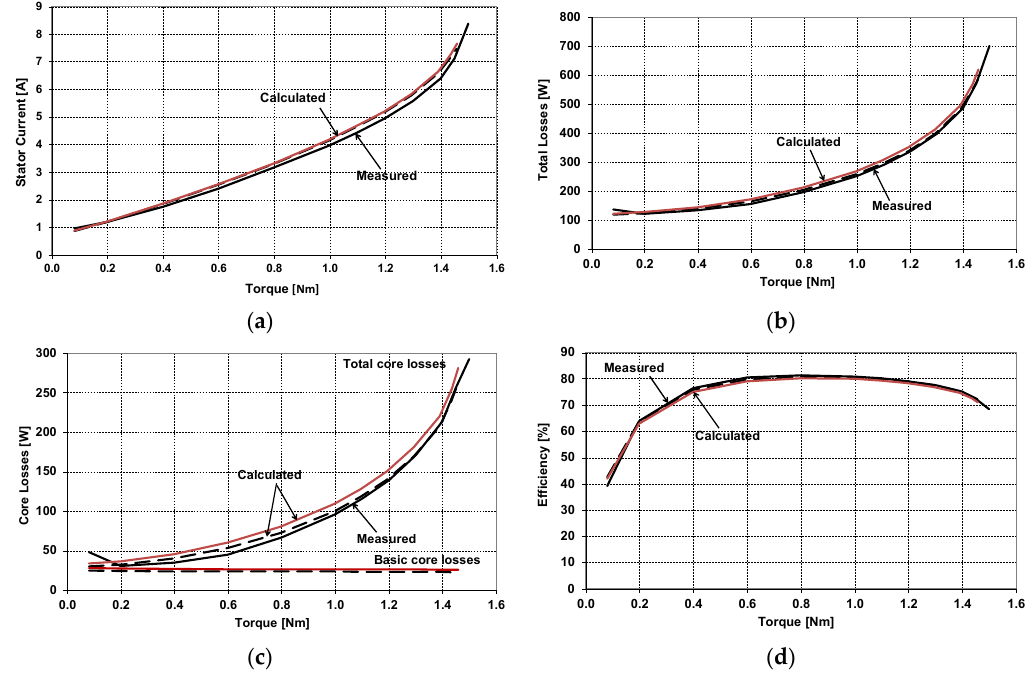
Figure 7. The measured at 350 Hz and calculated, stator current ( a ), total losses ( b ), core losses ( c ) and efficiency ( d ) for motor 1. Solid black curve—measured, dashed black curve—calculated for the characteristics measured for the specimen ring with a width of 10 mm, red one—calculated for the characteristics converted to the actual width of the teeth and yoke of the motor core.